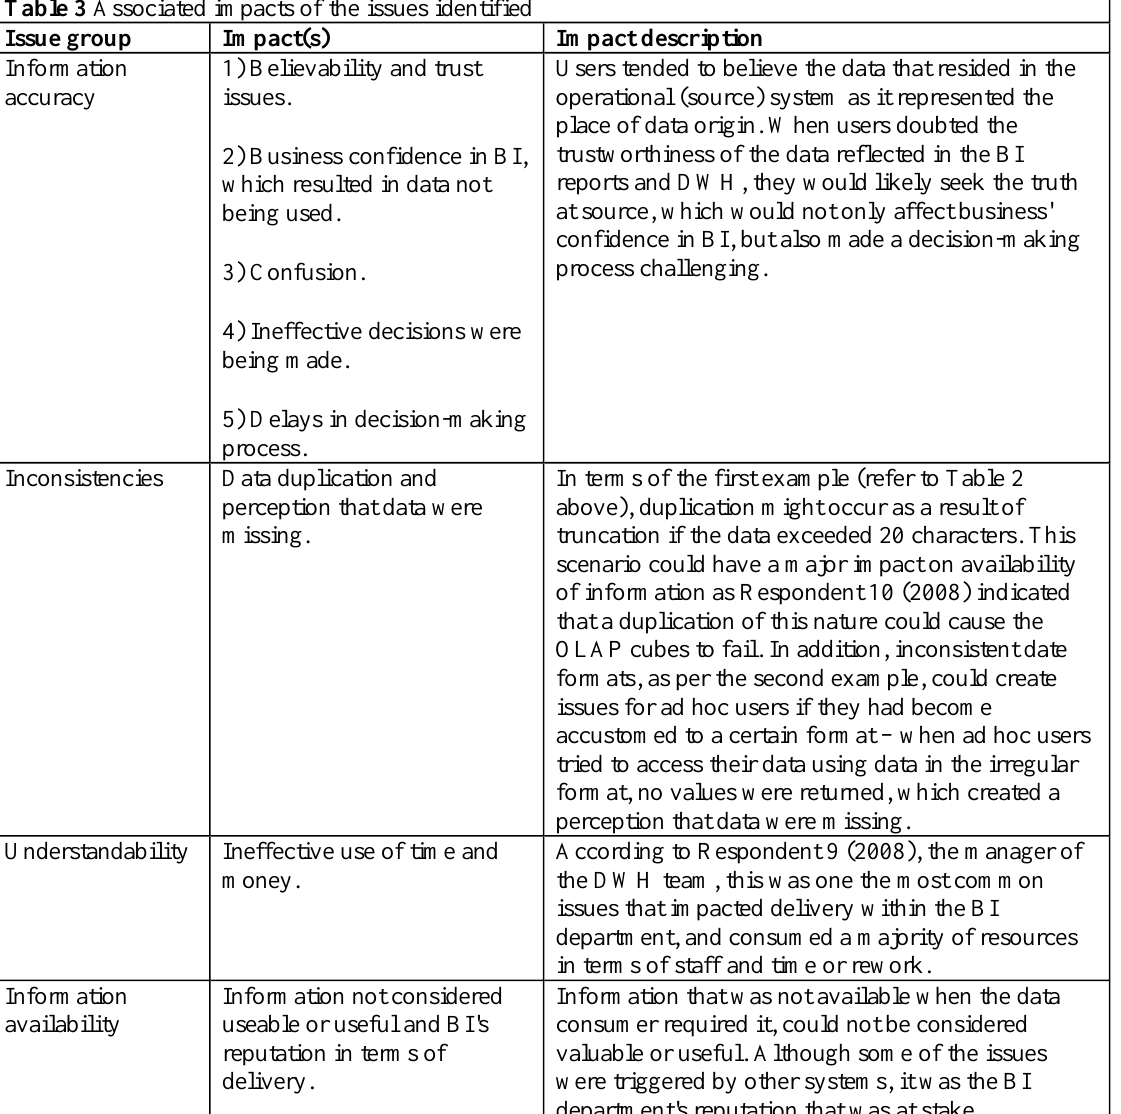
Table 3 Associated impacts of the issues